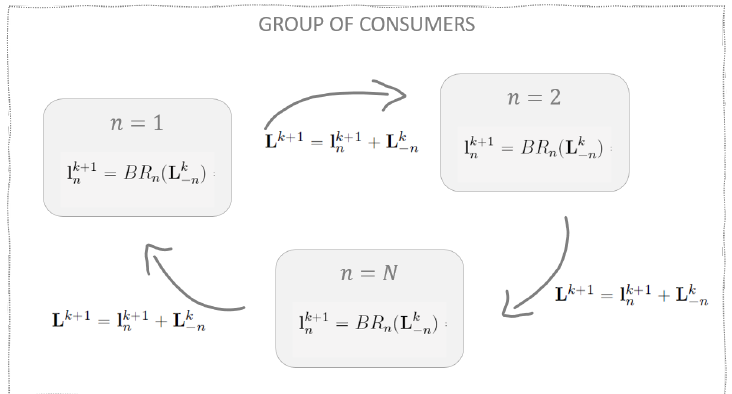
Figure 3. Solution algorithm to solve the proposed game model: consumers communicate the total load of the community, which guarantees information privacy.